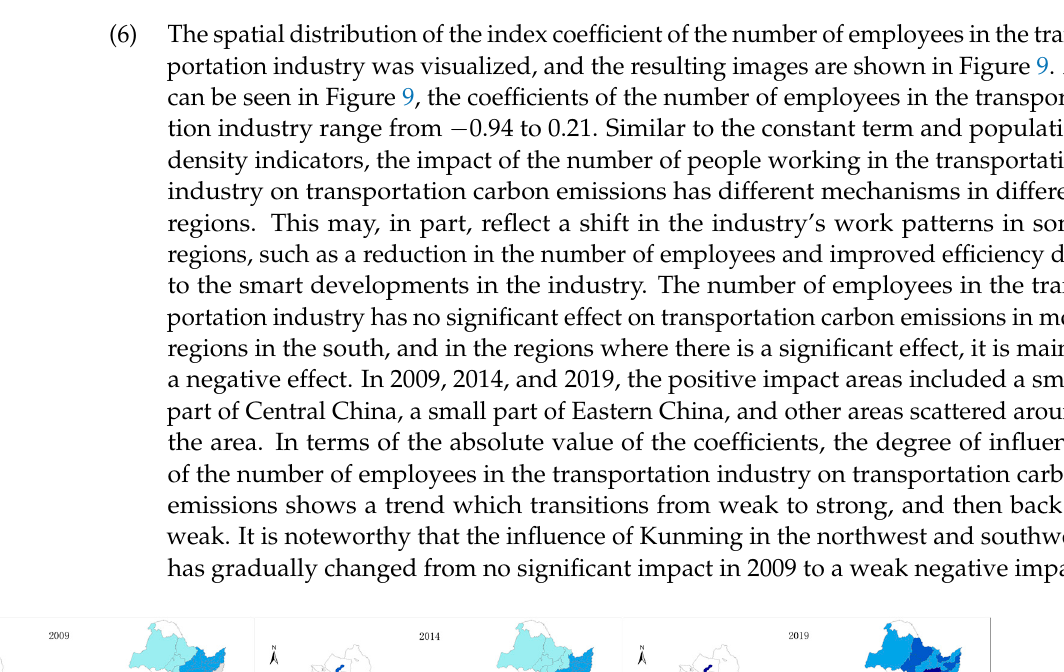
Figure 8. Spatial distribution of car ownership indicator coefficient.